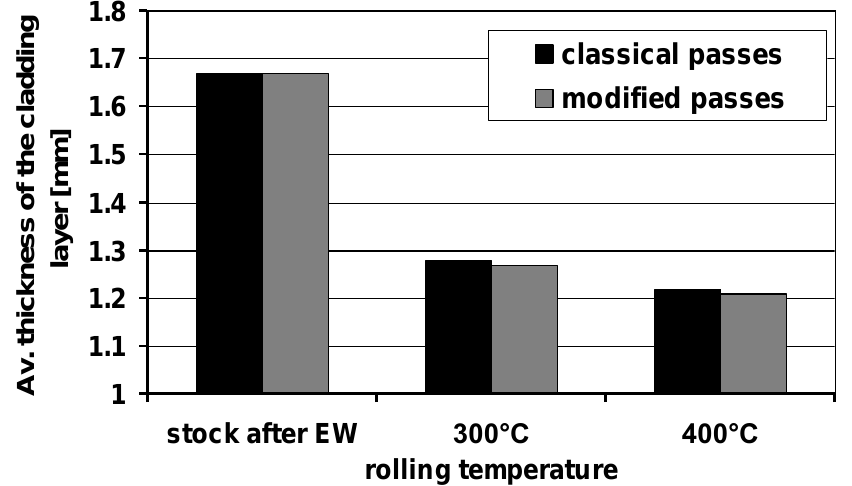
Figure 6. Average thickness of the plating layer around the perimeter of the magnesium core. The main idea of using modified grooves (variant II) was to limit the uncontrolled plastic flow of the plating layer, thanks to which it will be possible to obtain Mg/Al bars with a more even distribution of the plating layer around the perimeter of the magnesium core. Limiting the local thinning of the plating layer on the perimeter and obtaining its even distribution is an important factor impacting the corrosion resistance of Mg/Al bars. Figure 7 presents the results of the calculations of K plat coefficient calculated for finished bars rolled in two systems of